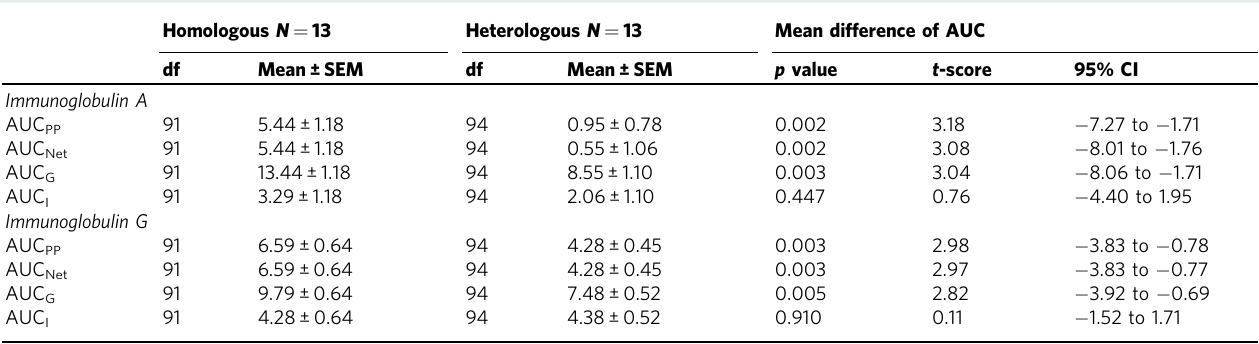
Table 2 Comparing the SARS-CoV-2-speci fi c antibody response in human milk following booster vaccination with an mRNA- based